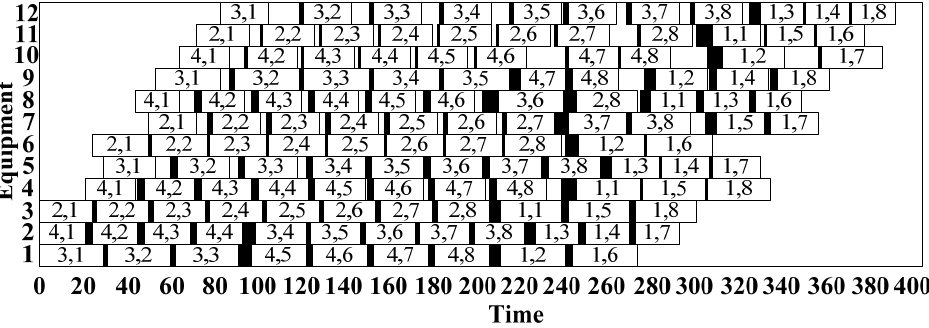
Figure 7. Gantt chart of a static scheduling.